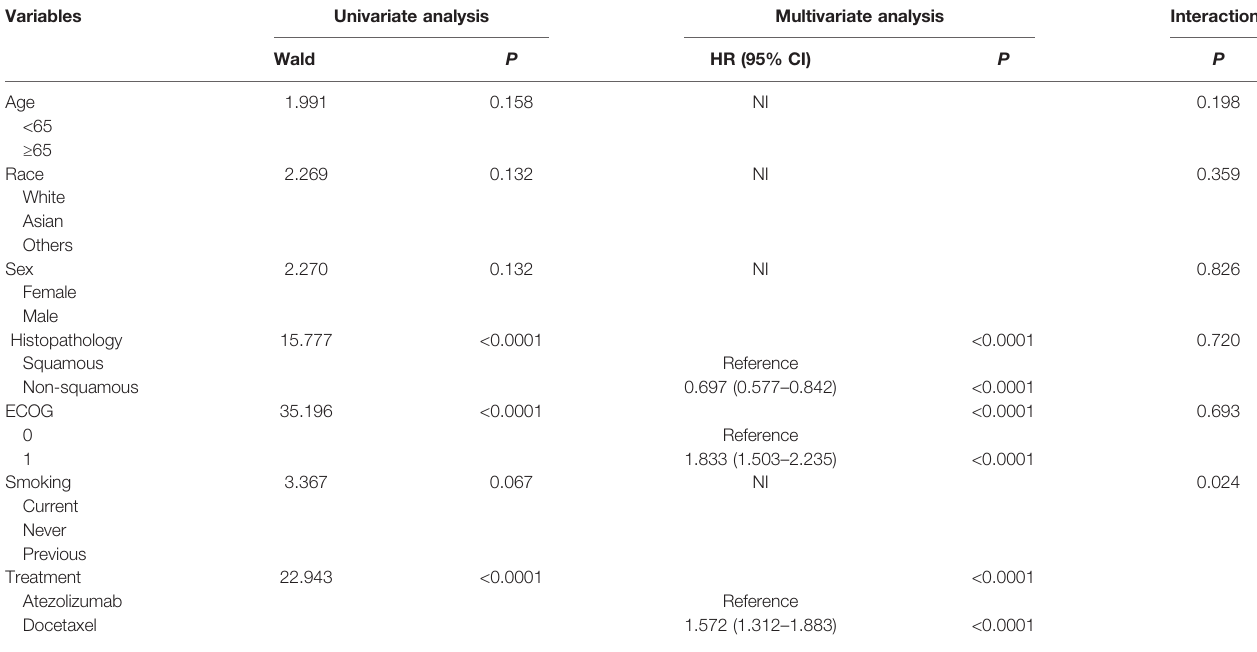
TABLE 2 | Univariate and multivariate Cox regression analysis of clinical variables affecting OS for low-risk patients based on training and testing group.